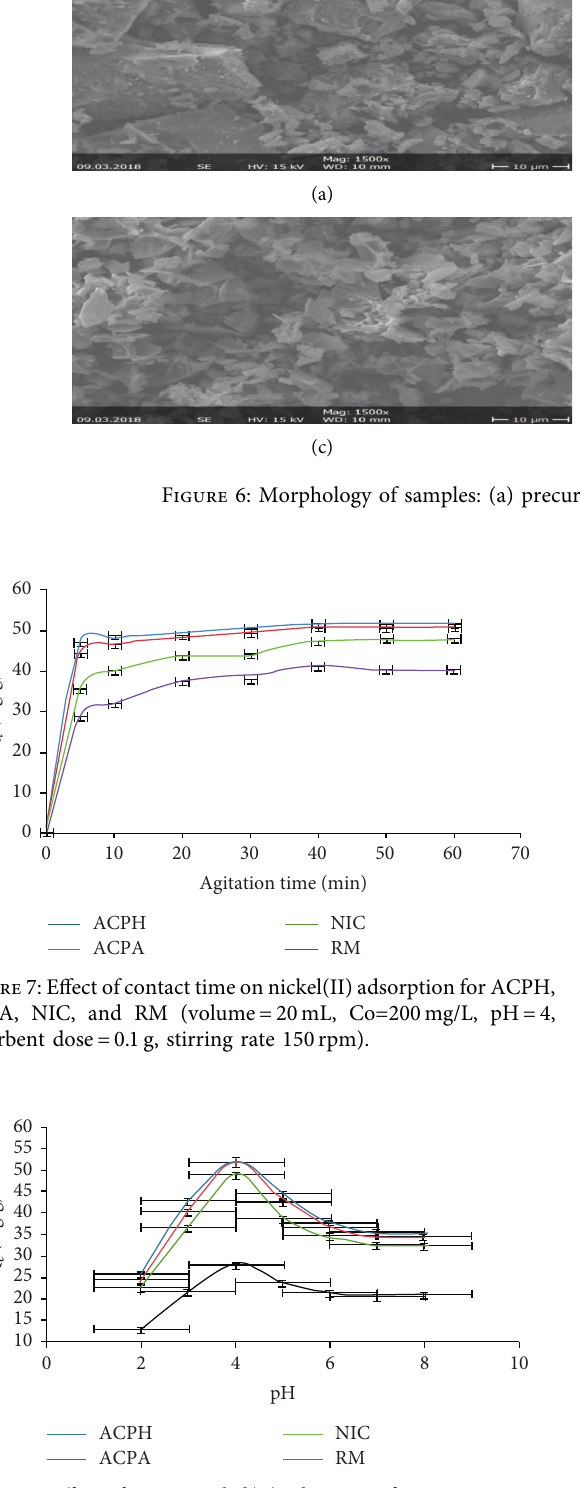
Figure 8: Effect of pH on nickel(II) adsorption for ACPH, ACPA, NIC, and RM (volume � 20mL, teq � 40min, Co � 200 mg/L, ad- sorbent dose � 0.1 g, stirring rate 150rpm).